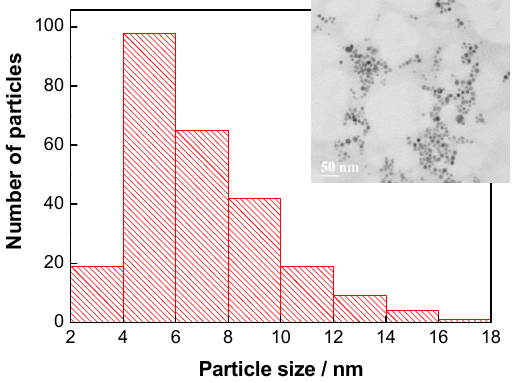
Figure 5. TEM-derived Ag NP size distribution in the presence of blocking reagent (BSA) (16 µ g · mL − 1 ) and TEM image of Ag NPs in the presence of BSA (16 µ g · mL − 1 ) (inset).